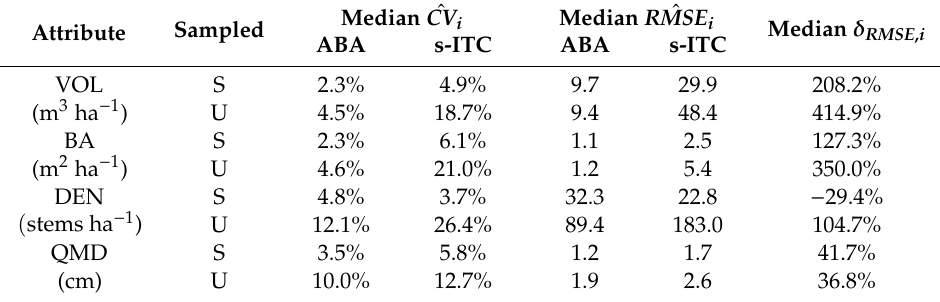
Table 6. Medians of estimated mean squared errors for stands partitioned by sampled (S) and unsampled (U)